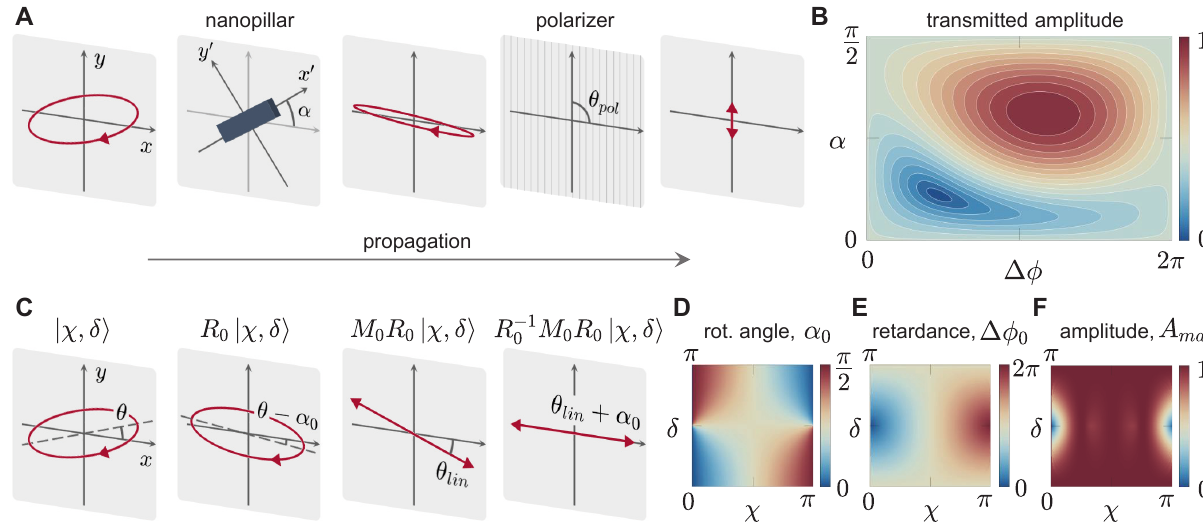
Figure 1: Mapping polarization to amplitude. (A) An arbitrary input polarization state is converted by a birefringent nanopillar into a new polarization state that, after passing through a polarizer, is reduced in amplitude. This approach still allows the phase of the output state to be controlled independently. The nanopillar orientation angle and polarizer axis are α and θ pol , respectively. (B) Contour plot showing the transmitted amplitude of the elliptical state shown inA after propagationthrough the nanopillar – polarizersystem as a function of the orientationangle α and phase retardance Δ ϕ of the pillar. (C) Conditions to achieve amplitude extinction through the nanopillar – polarizer system when the polarizer axis is aligned along the (cid:4)(cid:4)(cid:4)(cid:4) χ , δ 〉 that is rotated by an angle α y -axis. The input is an arbitrary polarization state 0 in the nanopillar frame of reference (operator R 0 ), linearizedviabirefringence(operator M 0 ),and fi nallybroughtbacktotheoriginalframeof reference(operator R − 1 )resultingorthogonaltothe 0 polarizer axis. (D and E) Design parameter maps corresponding to the pillar angle and phase retardance needed to obtain extinction for any input polarization state, represented in the ( χ , δ ) plane. (F) Maximumamplitudetransmissionthrough the nanopillar – polarizationsystem for any input state when the phase retardance is fi xed to Δ ϕ and only α is adjusted. If instead both parameters are allowed to vary a full 0 modulation range from 0 to 1 can be achieved, as in